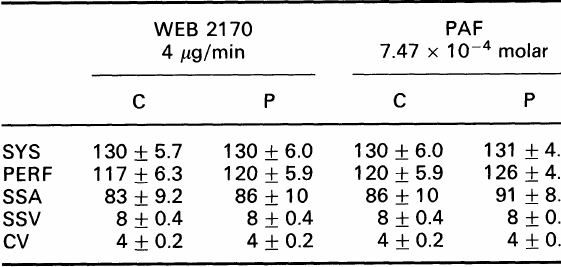
Table 3. Effects of intralymphatic PAF infusion during the intra-arterial infusion of WEB 2170 on vascular